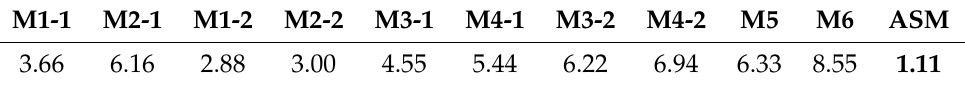
Table 4. Average rank of 10 frameworks and the ASM approach on 18 problems based on Wilcoxon rank-sum test.